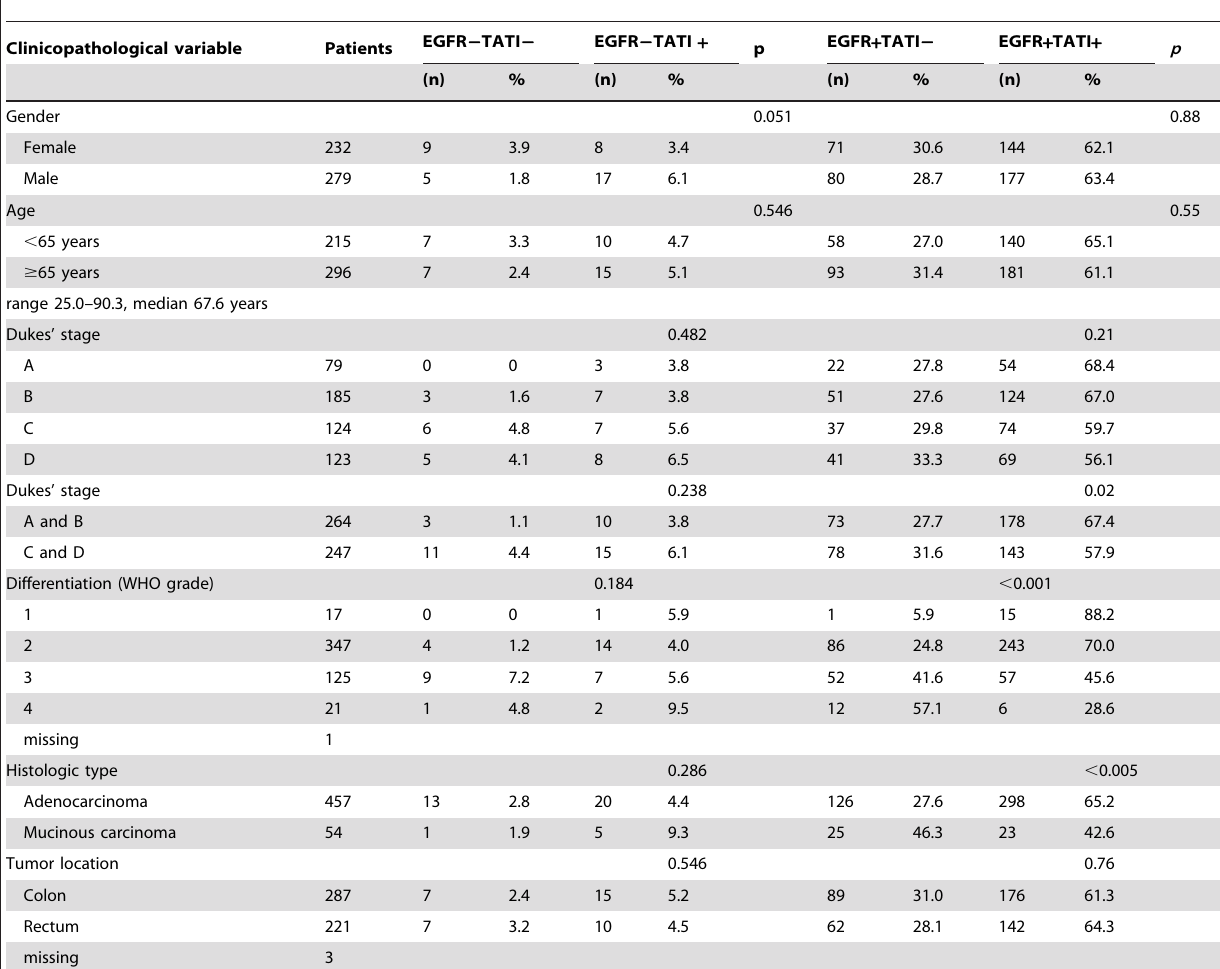
Table 2. Patient clinicopathological characteristics and their correlation with EGFR and TATI immunoreactivity in 511 colorectal cancer patients assessed with chi-square